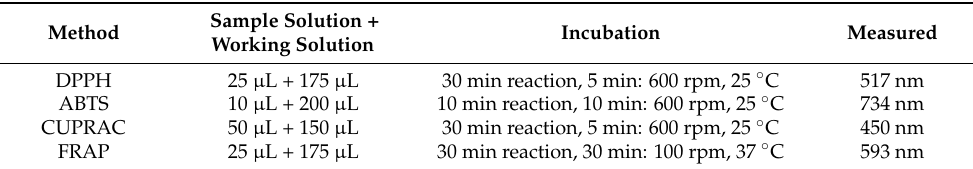
Table 2. The most important parameters of DPPH, ABTS, CUPRAC, and FRAP activity.